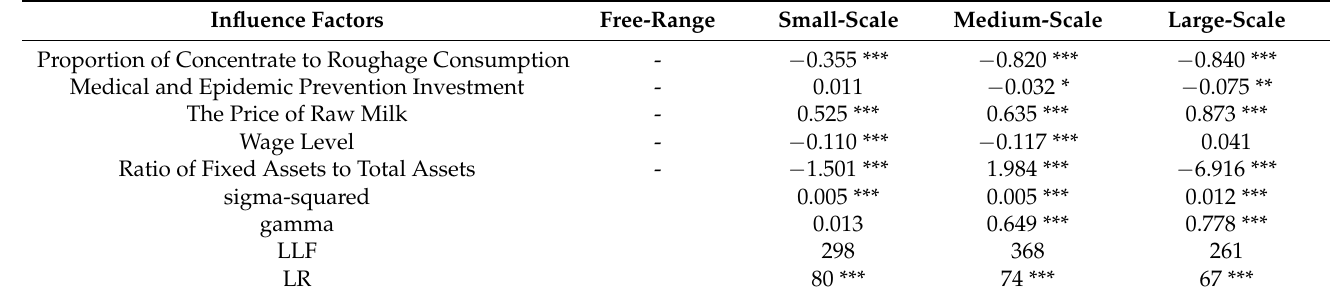
Table 7. Parameter estimation of technical inefficiency